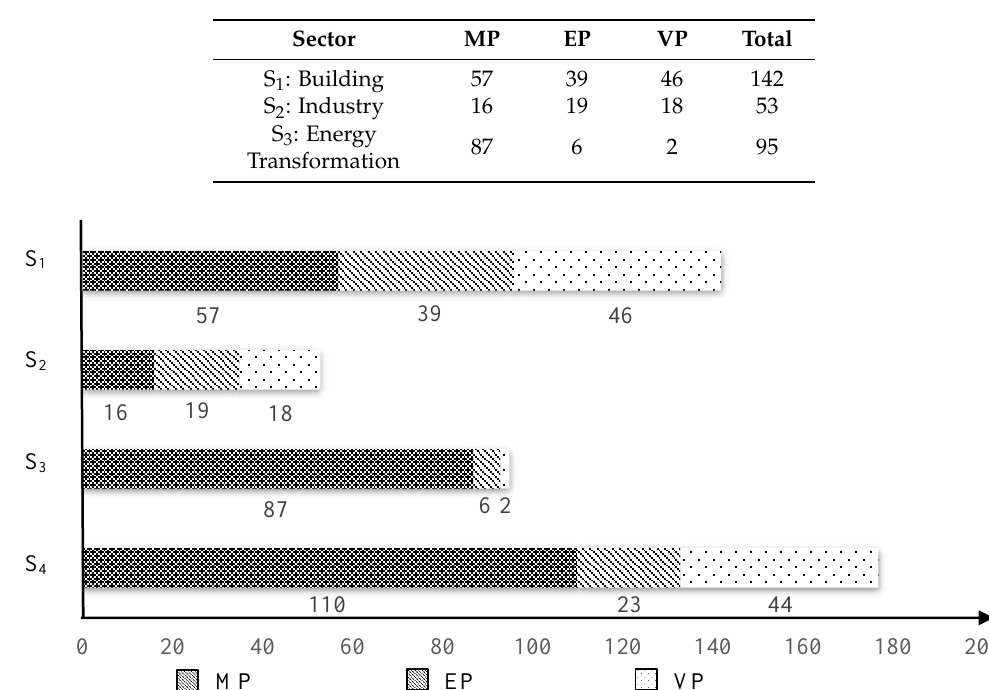
Figure 6. The number of the three kinds of carbon reduction policies adopted in four emission sectors.